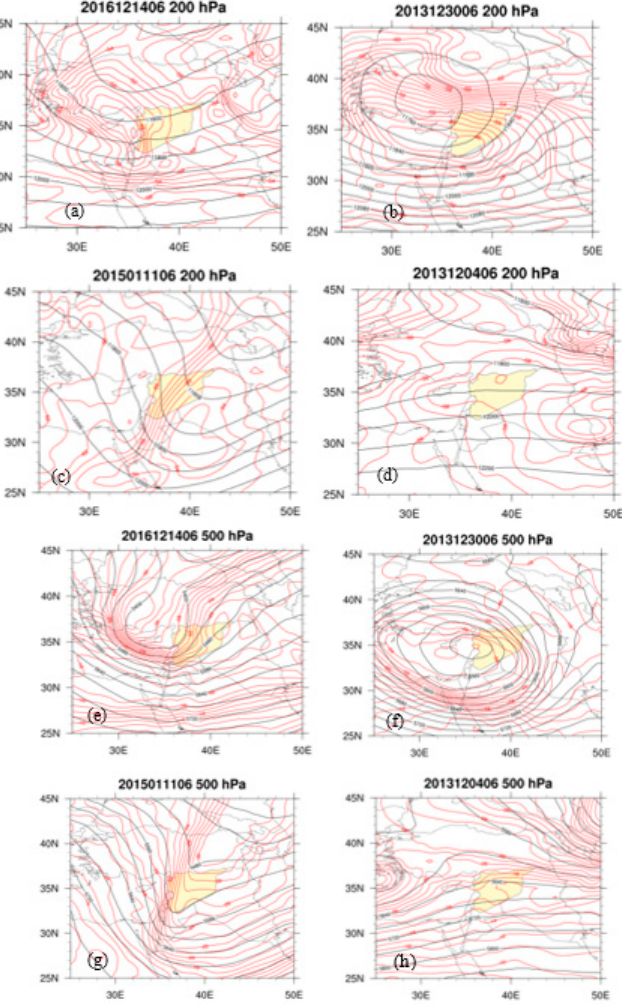
Figure 4. Typical circulations at 200 and 500 hPa during rainfall days (200 hPa: ( a ) 20161214, ( b ) 20131230, ( c ) 20150111, ( d ) 20131204; 500 hPa: ( e ) 20161214, ( f ) 20131230, ( g ) 20150111, ( h ) 20131204). The region shaded yellow is Syria. The red line indicates the contour of temperature (unit: °C) and the black line indicates the contour of geopotential height (unit gpm).